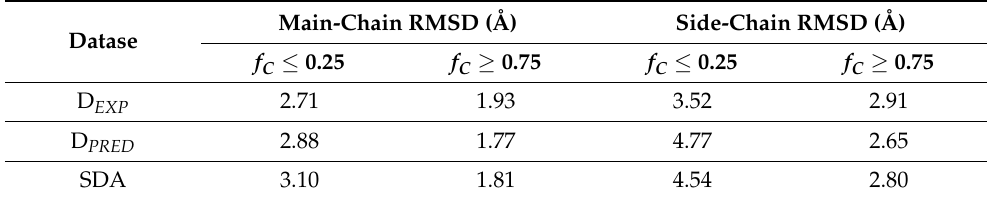
Table 1. Structural variations in specific assemblies of experimentally identified (D EXP ) and predicted (D PRED ) droplet-forming proteins and specific disordered assemblies (SDA). Root-mean-square deviations (RMSD) are computed for residues establishing partner contacts in less than 0.25 of the models ( f C ≤ 0.25) and residues forming contacts in more than 0.75 of the models ( f C ≥ 0.75); f C = N C /N TOTAL , where N C is the number of models when the residue is in contact, and N TOTAL is the number of all